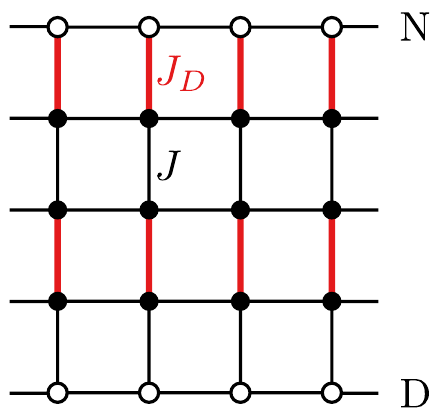
Figure 9: The quantum spin model considered in Refs. [ 9, 43 ] (figure taken from FIG. 1. Columnar dimer lattice with non-dangling edge Ref. [ 43 ] ). Red bonds have stronger coupling J and black bonds have weaker cou- D spins (N, top edge) and dangling edge spins (D, bottom edge). pling J . N and D mark edges with non-dangling and dangling spins Solid (open) circles show bulk (edge) spins, and thick red (thin black) lines denote intra- (inter-) dimer couplings, J ( J ). D